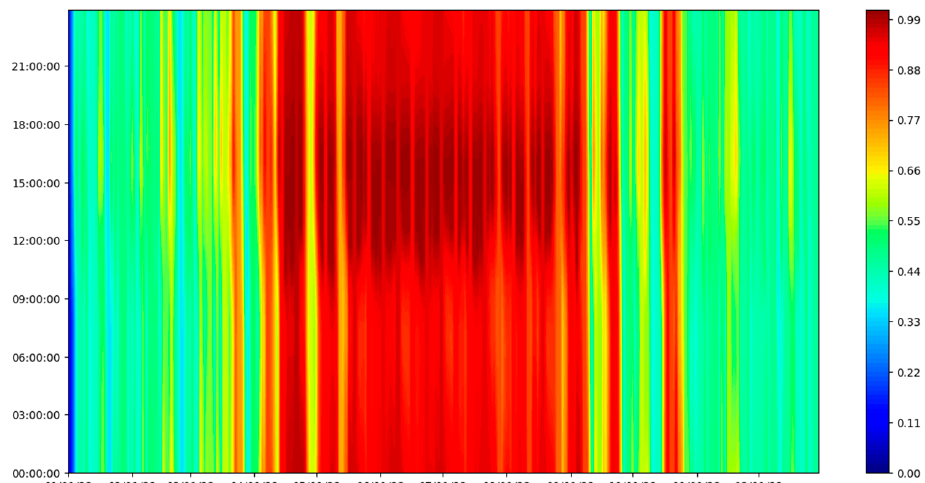
Figure 7. Battery state of charge as a function of the day (horizontal axis) and the hour of day (vertical axis).